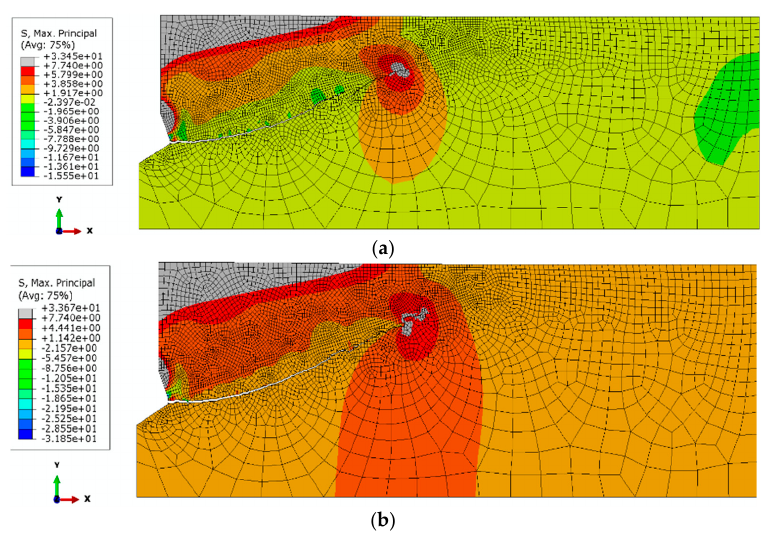
Figure 7. The course of the damage propagation and the distribution of maximum scheme is 14,276 MPa, μ = 0.4; β = 20° and Poisson’s Ratio, ( a ) ν 1 = 0.15; ( b ) ν 2 = 0.20.